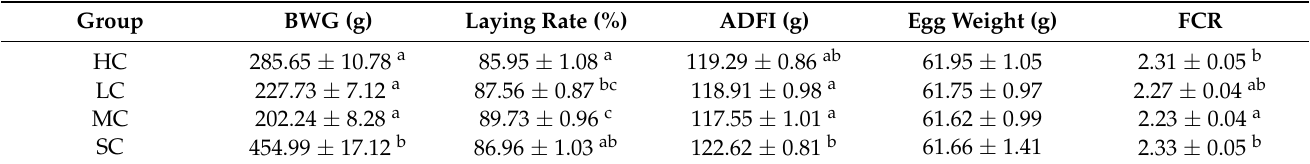
Table 2. Effects of cage size on the overall production performance of laying hens from 46 to 60 weeks of age.